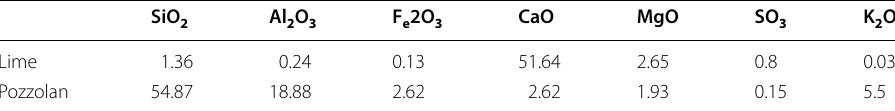
Table 3 Percentage of minerals in the additives